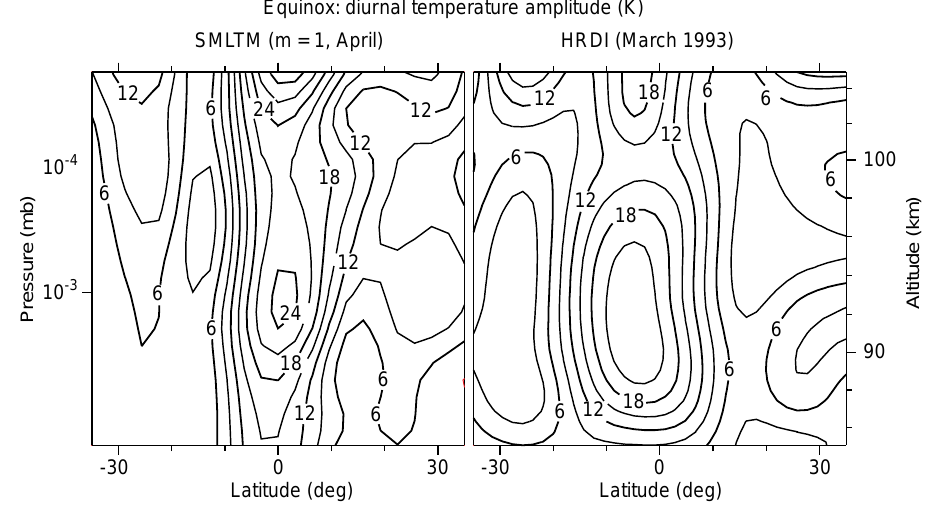
Fig. 3. Diurnal tidal amplitude for temperature (contour interval 3 K): SMLTM simulations ( m (cid:136) 1) for April ( left panel ); HRDI diurnal tidal amplitude for March 1993 ( right